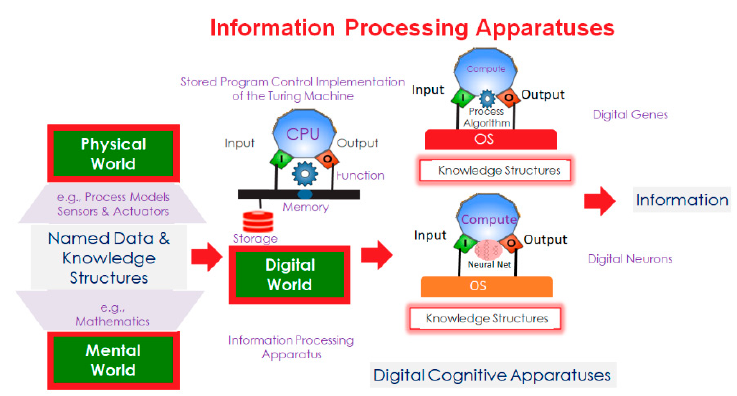
Figure 1. The world of structures and digital information